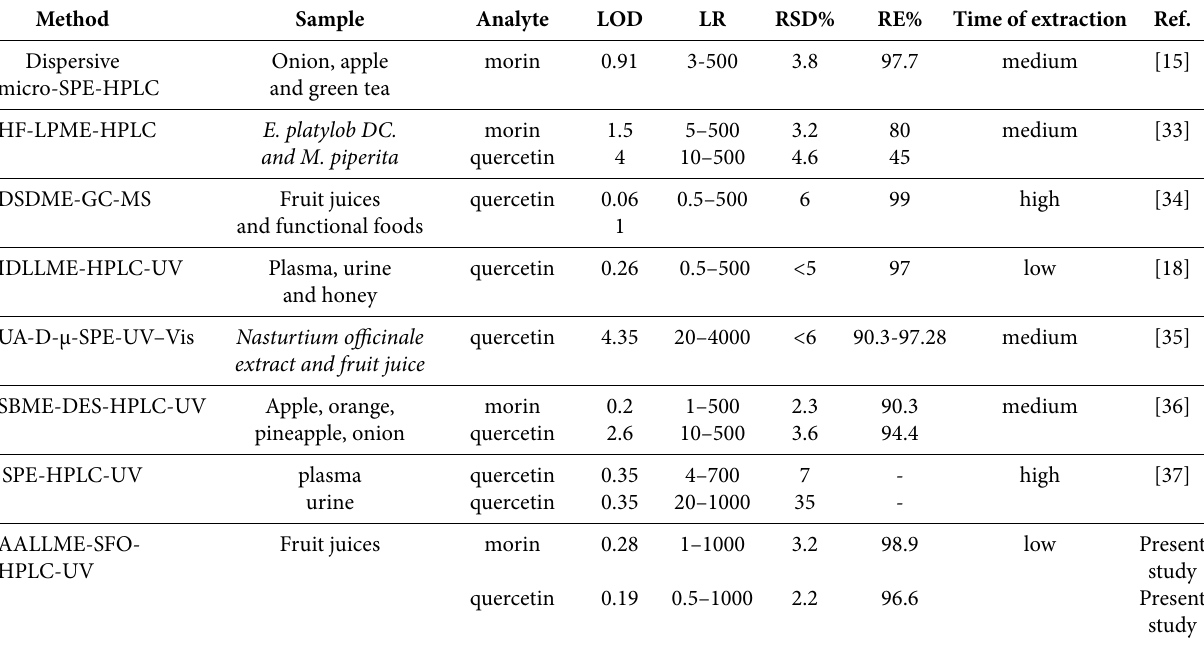
Table 4. Comparison between the presented method and other reported methods for the determination of morin and quercetin